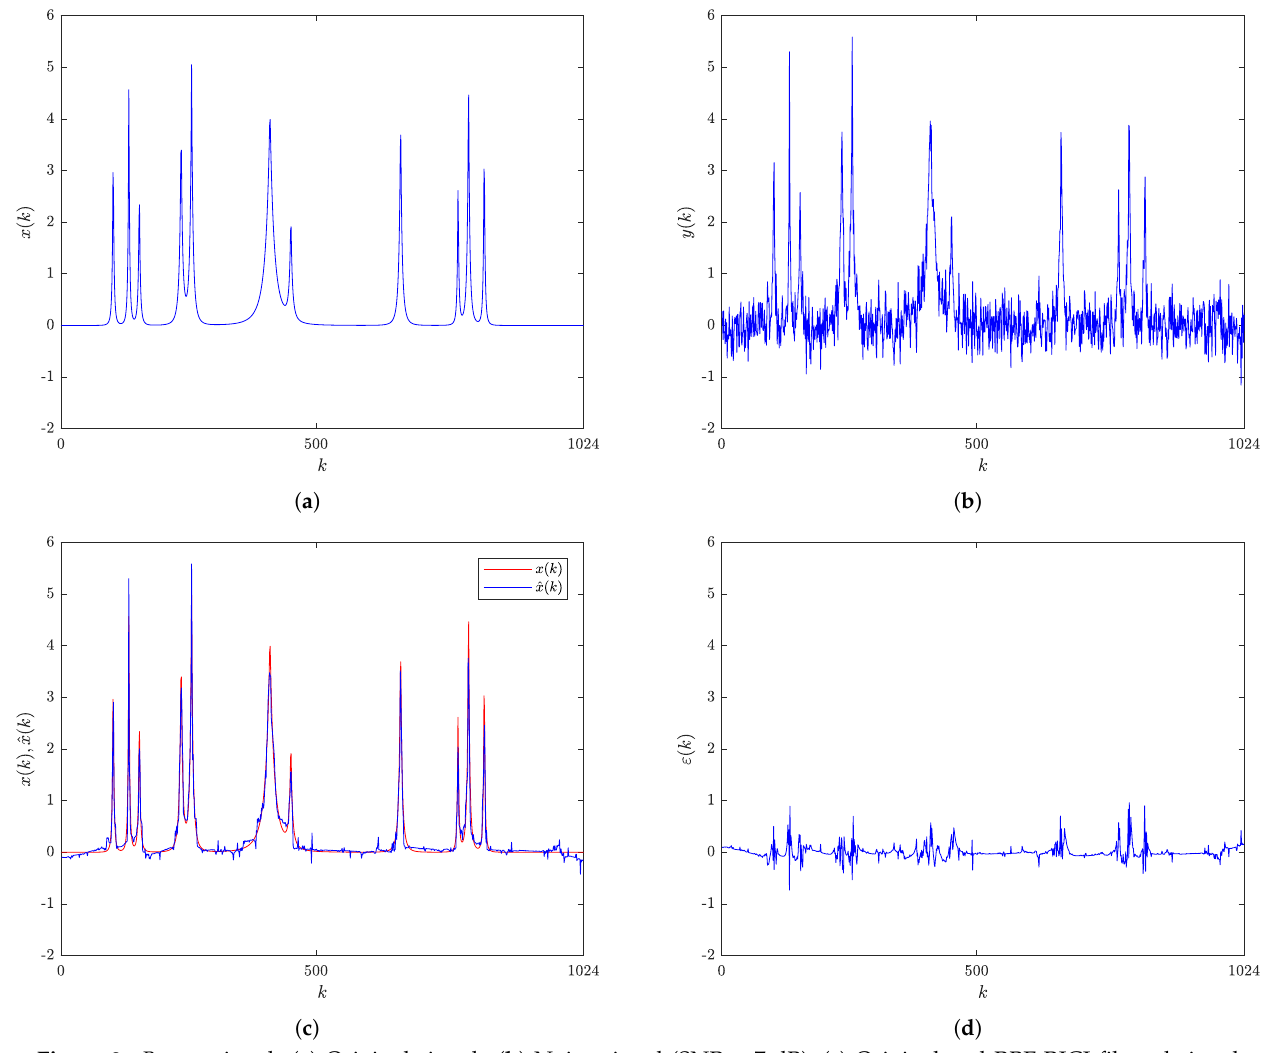
Figure 2. Bumps signal: ( a ) Original signal. ( b ) Noisy signal (SNR = 7 dB). ( c ) Original and RBF-RICI filtered signal ( Γ = 0.82, R c = 0.33). ( d ) Filtering error. Table 8. Bumps signal (SNR = 5 dB)—Filtering